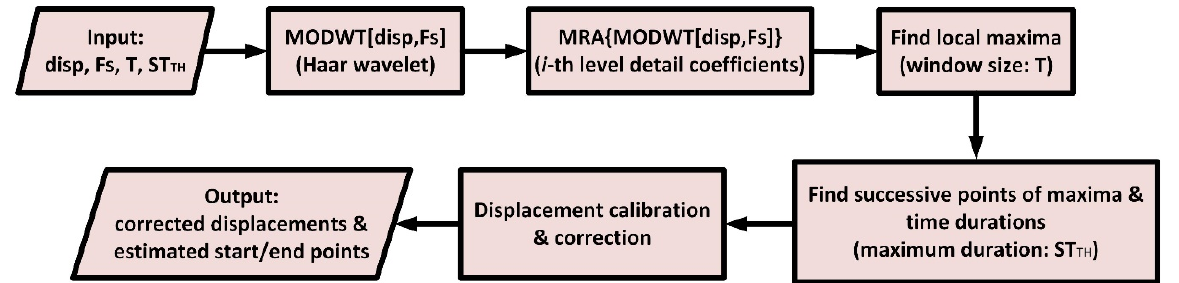
Figure 2. Flowchart of the MODWT-based algorithm.